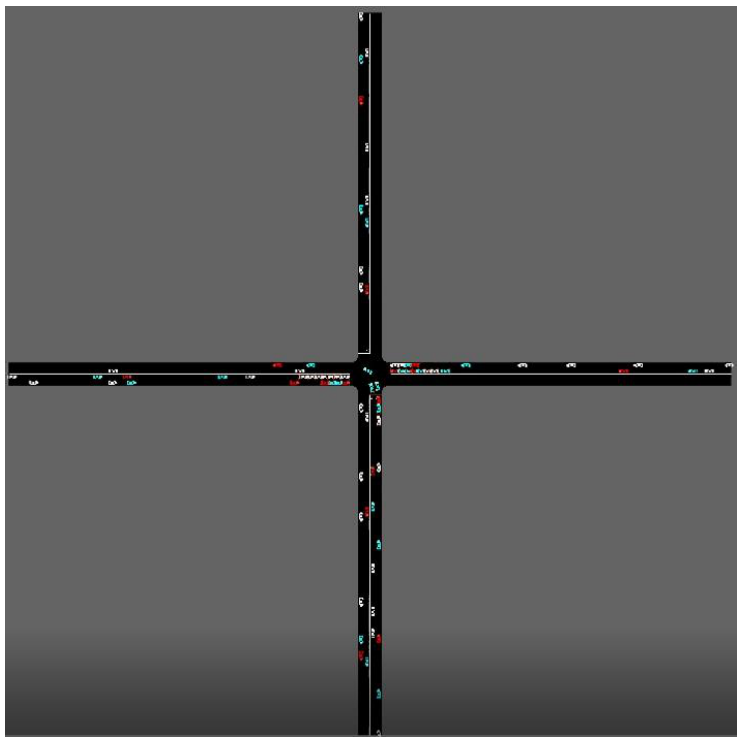
Figure 2. A typical simulation in SUMO.